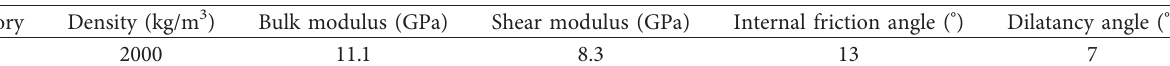
Table 4: Mechanical parameters of main rock materials in the